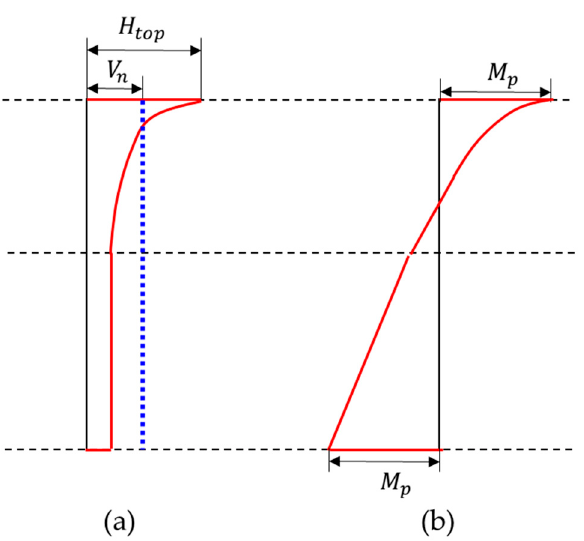
Figure 11. Shear force and bending moment diagrams of the windward column subjected to reaction from masonry infill. ( a ) Shear force diagram. ( b ) Bending moment diagram